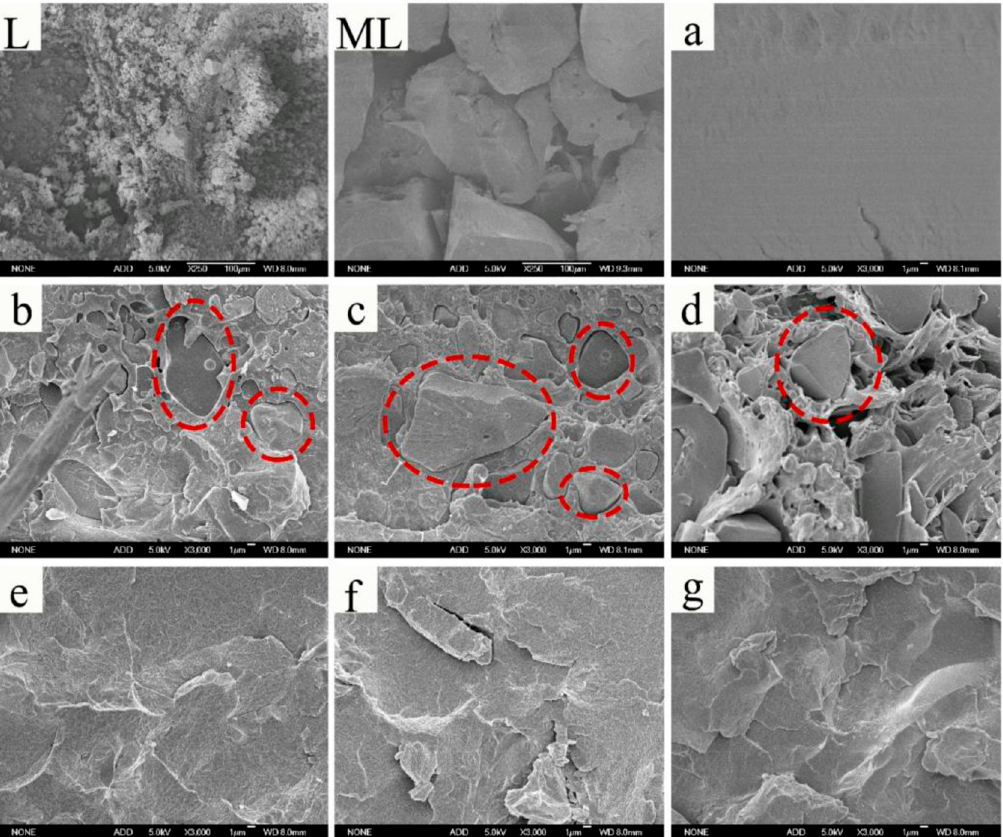
Figure 10. SEM micrographs of lignin (L), methylated lignin (ML) and surface morphologies of ( a ) neat PBTA film and PBTA/L ( w / w ) composite films: ( b ) 60/40, ( c ) 50/50, ( d ) 40/60 and PBTA/ML composite films ( w / w ): ( e ) 60/40, (f) 50/50, ( g ) 40/60. Reprinted from [67] with permission from American Chemical Society © 2020.